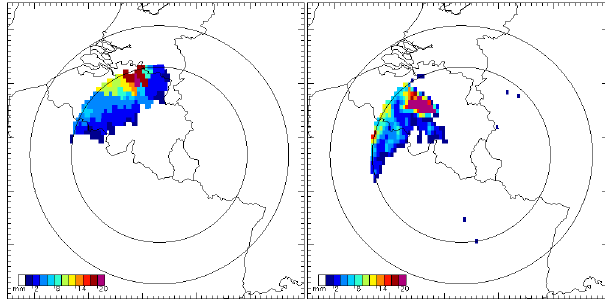
Fig. 10. Satellite (PR-OBS-4 on the left) and radar (on the right) images observed at 01:00UTC on 26 May 2009. The radar image on the right is the result of the up-scaling of the Wideumont, Bel- gium, radar data onto the PR-OBS-4 grid. It is possible to observe here that the PR-OBS-4 product was able to detect the main pre- cipitation zone. However, the area with the high precipitation rates appears to be shifted to the northeast, surrounded by a more ex- tended precipitation zone than in the radar case. The small and big circles indicate the area respectively with a radius of 160km and 240km.